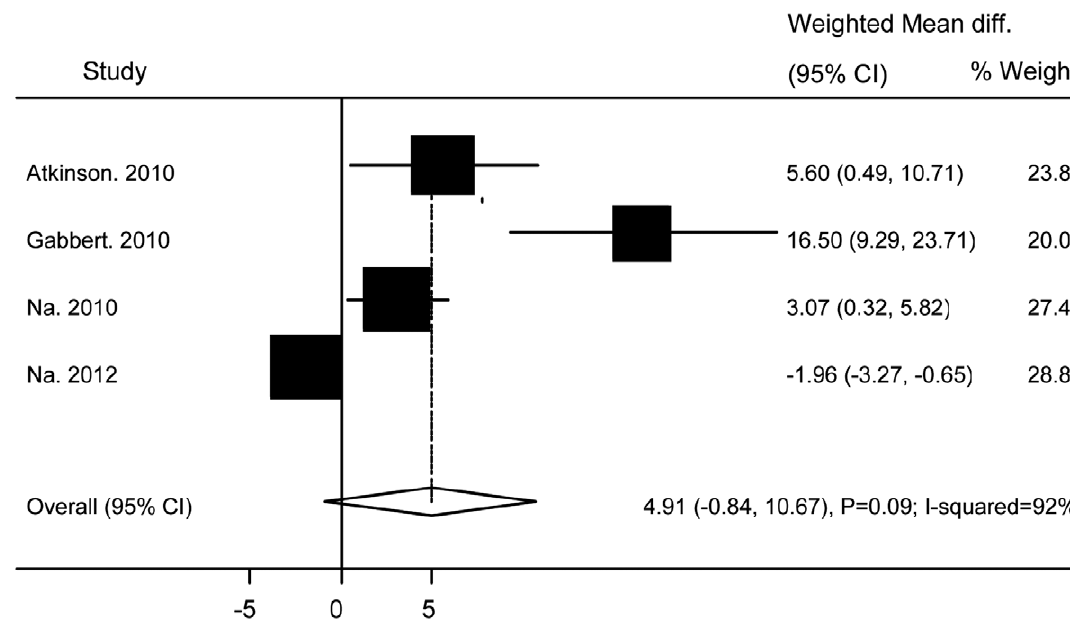
Figure 8. Association of Ad36 with Waist Circumstance.